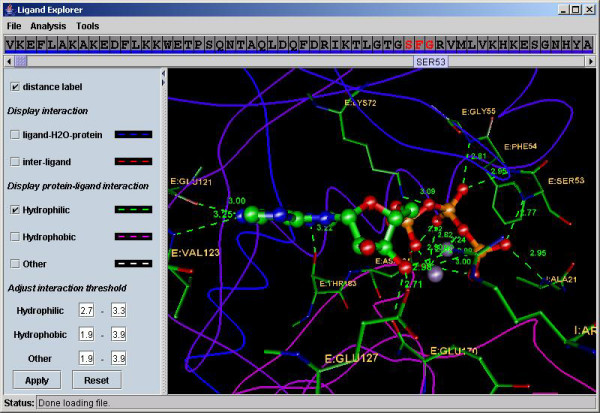
Ligand Explorer. The structure of cAMP dependant protein kinase (PDB id 1ATP) showing the hydrophilic interactions of the bound ATP to the protein and bound inhibitor which mimics substrate in the phosphotransfer reaction from the gamma phosphate of ATP.